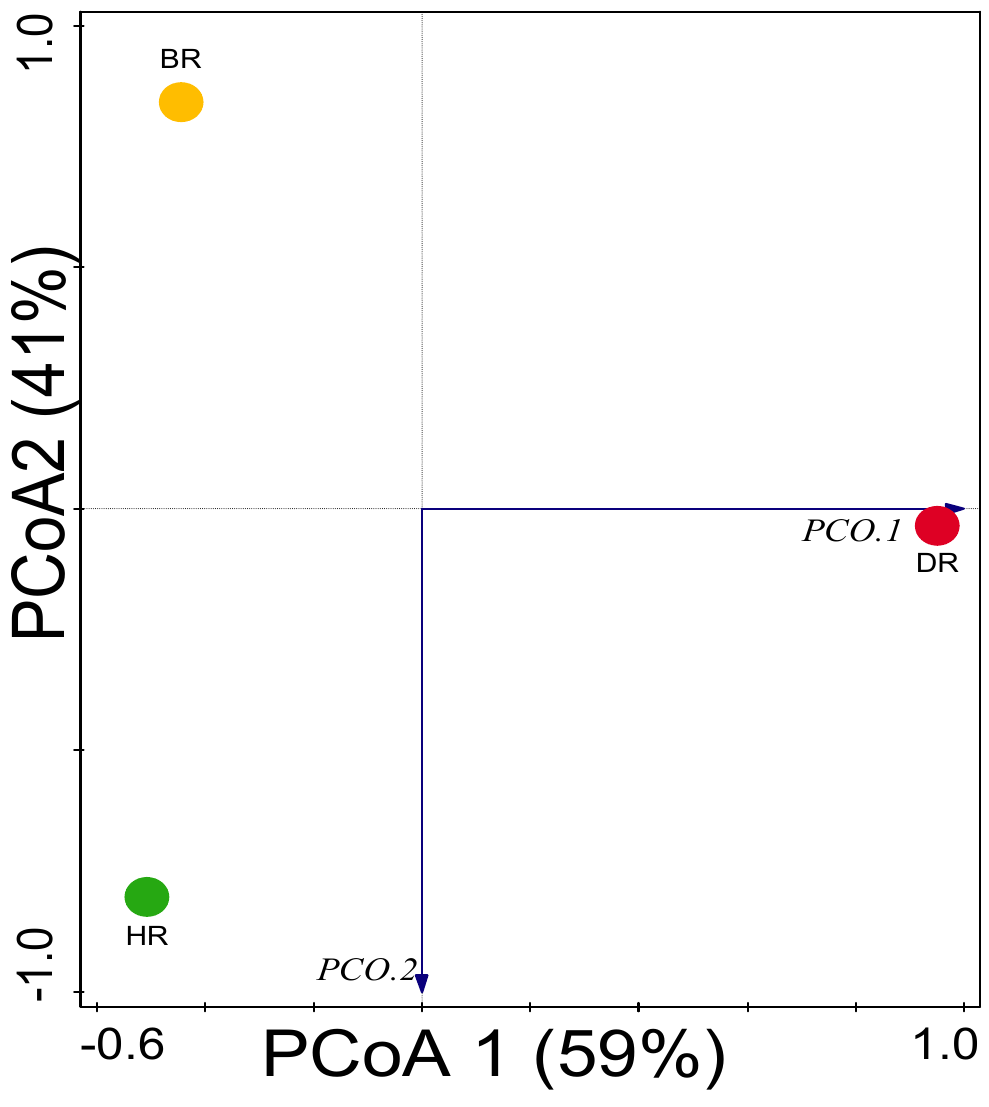
Table 1. Diversity and evenness of microbial communities present in the rhizosphere and bulk soil samples.